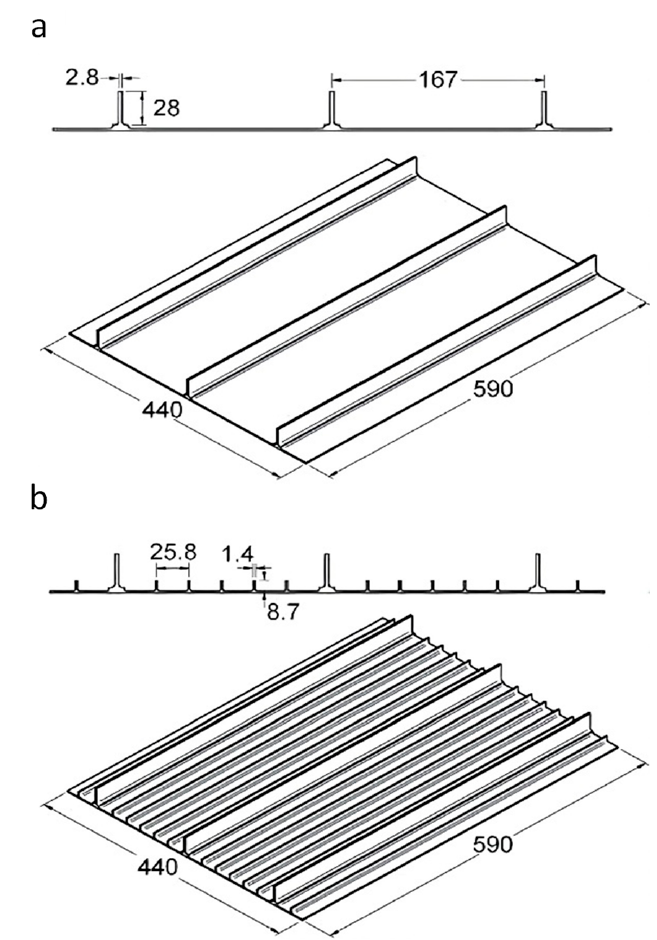
Figure 4. Test specimen geometry. ( a ) Specimen A and ( b ) Specimen B [41].